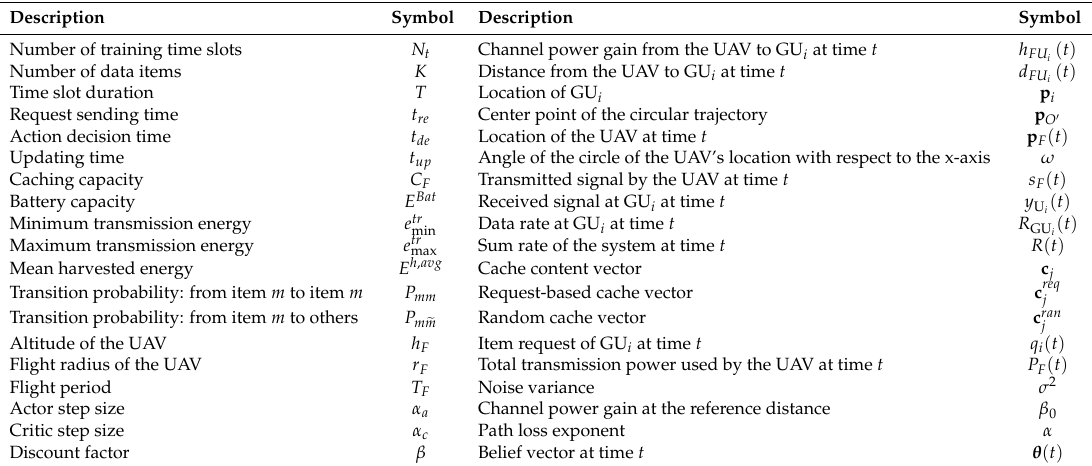
Table 1. Summary of symbols and